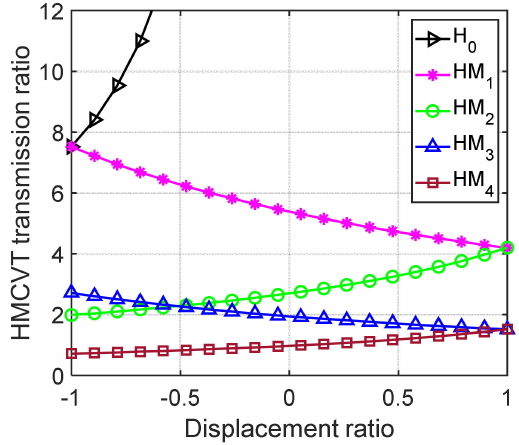
Figure 2. Variation characteristics of HMCVT’s transmission ratio.